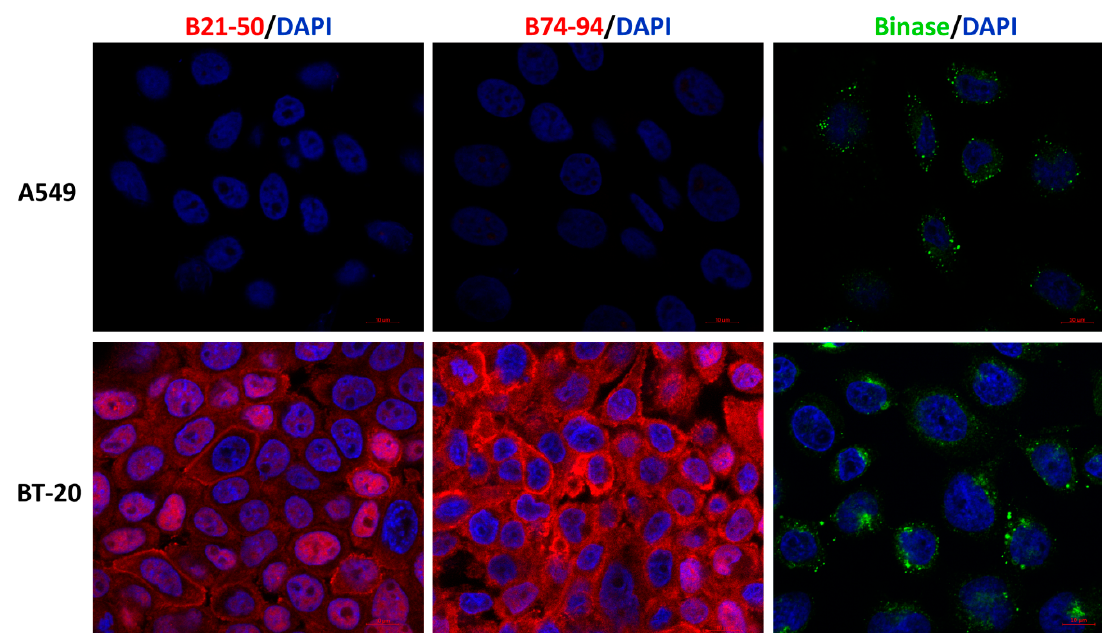
Figure 3. Confocal laser scanning images of A549 and BT-20 cells treated with His-tagged B21–50 and B74–94 peptides or binase. Peptides (red), binase (green), and nuclei (blue) were stained using anti-His-probe Alexa Fluor 647-conjugated mouse monoclonal antibodies, FITC-conjugated mouse anti-rabbit IgG (H+L) cross-adsorbed secondary antibodies and DAPI, respectively. Scale bars represent 10 µ